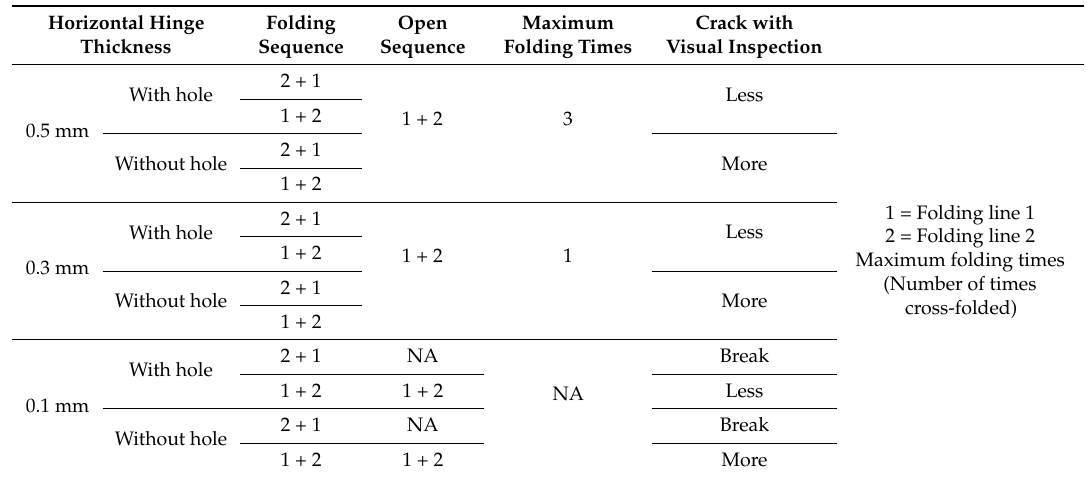
Table 3. Single material crossfolding.